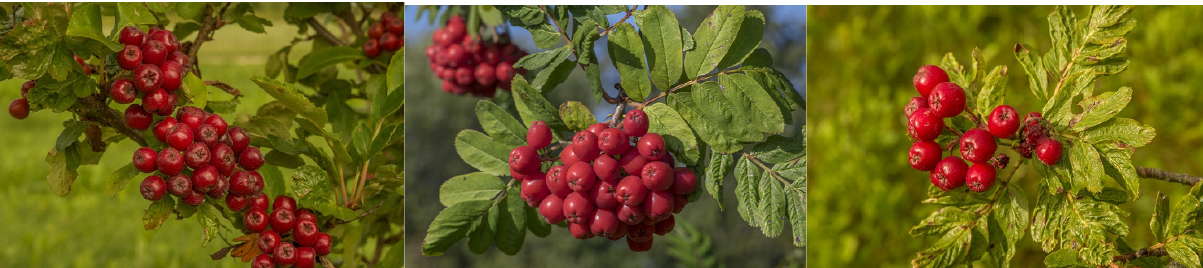
Figure 1. Rowanberry cultivars ‘Likernaja’, ‘Alaja Krupnaja’ and ‘Granatnaja’.